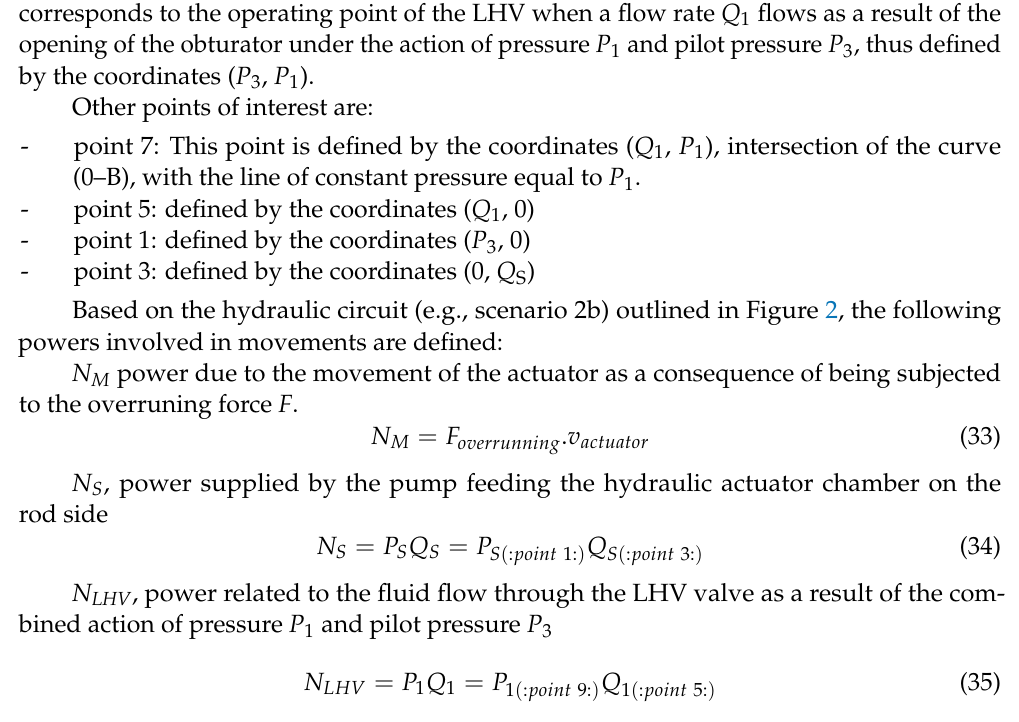
to zero force. It corresponds to the representation of Equation (3). jected to an overrunning force, F = constant. Curve 10–B: characteristic curve P = f ( Q ) of the LHV valve acting as a pressure limiting valve (relief function). See Equation (28). Curve O–7–B: LHV poppet pressure drop in the open position as a result of the shutter opening due to the action of the pressure P 1 and the pilot pressure P 3 . See Equation